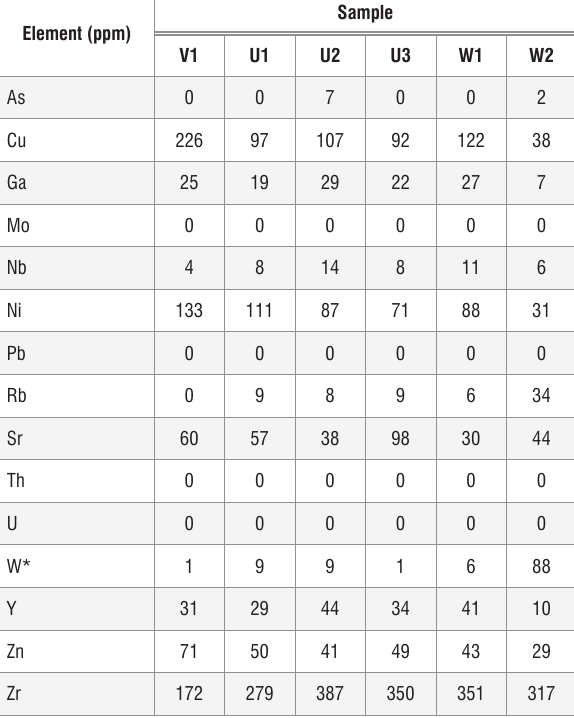
Trace metal content determined by X-ray fluorescence spectroscopy